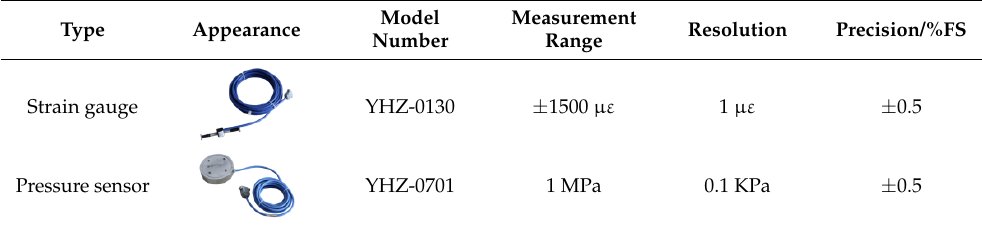
Table 1. Main parameters of the measurement equipment.